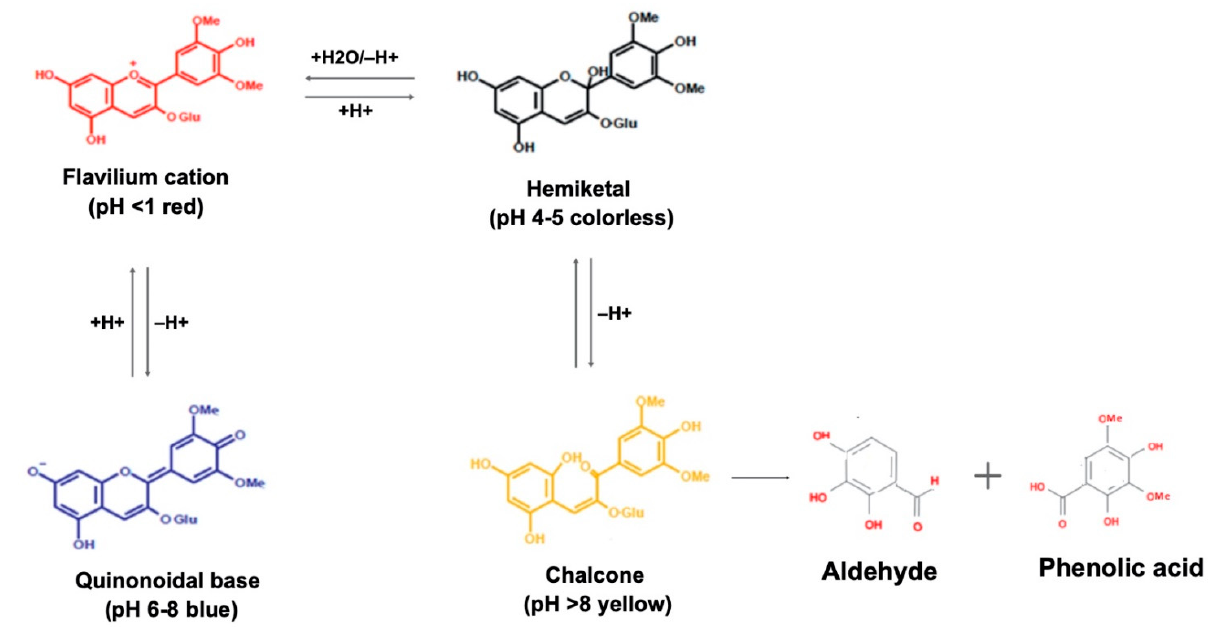
Figure 2. Structural transformation of anthocyanidins at acidic to neutral conditions. The figure was created with Mind the Graph (https://mindthegraph.com (accessed on 11 February 2022)).